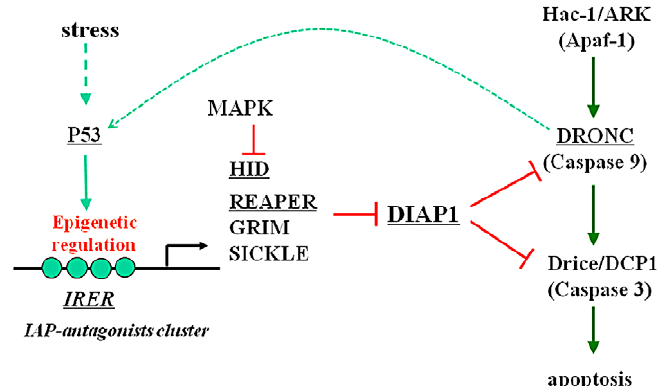
Figure 1. A simplified diagram of apoptosis regulation in Drosophila . The RHG genes are clustered in a chromosomal region of about 350 kb. Their transcription is coordinated by highly conserved intergenic regulatory regions such as IRER (irradiation responsive enhancer region). Cytotoxic stress such as DNA damage can activate P53, which in turn induces the expression of RHG genes. RHG proteins function as IAP-antagonists to relieve the caspase from inhibition by DIAP (Drosophila Inhibitor of Apoptosis). The relative human orthologs are in parenthesis. Arrows indicate activation and red bars indicate suppression. Dotted lines represent indirect relationship. The genes that were analyzed in this work for their role in mediating the rapid induction of apoptosis following viral infection are